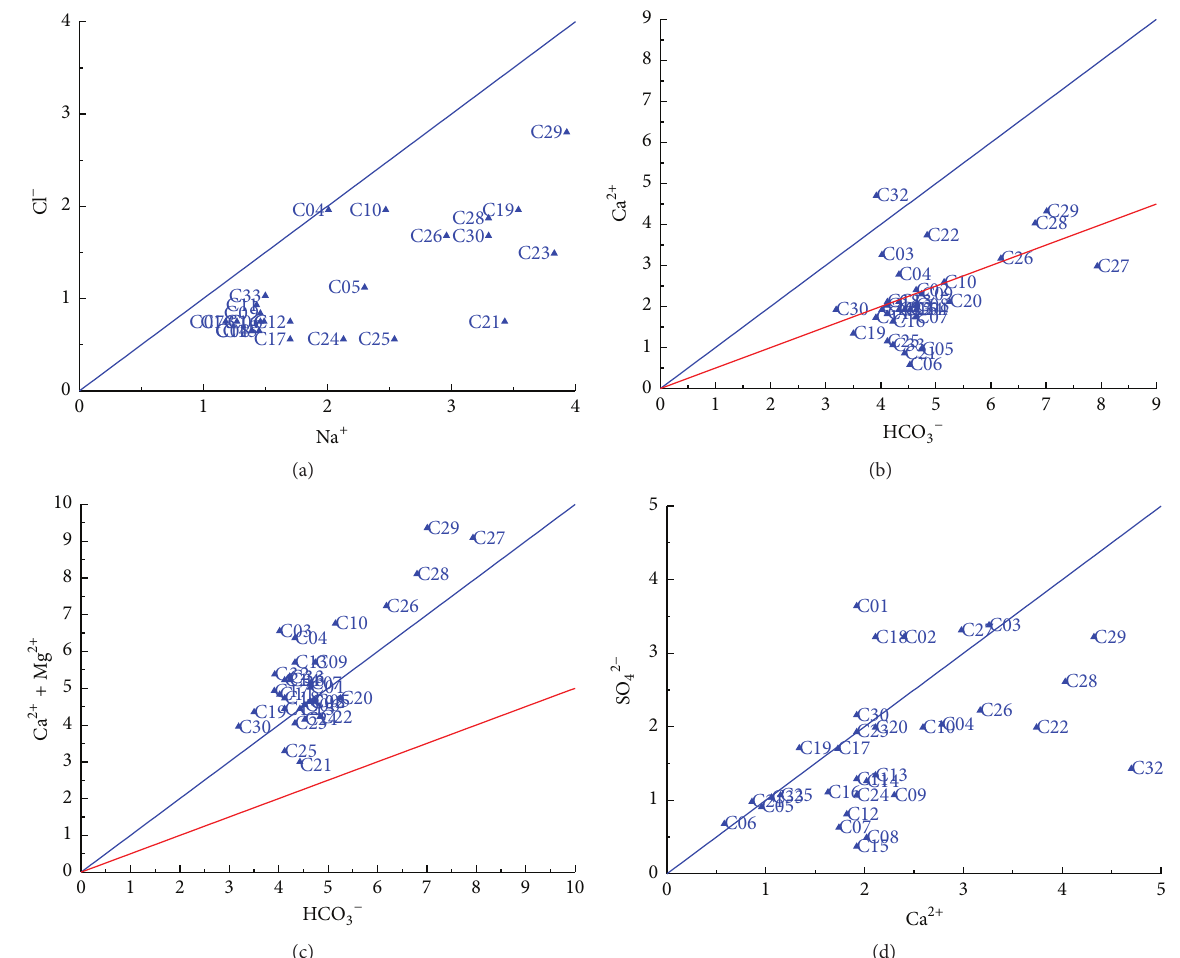
Figure 6: Plots of (a) Na + versus Cl − , (b) Ca 2+ against HCO 3− , (c) Ca 2+ + Mg 2+ against HCO 3− , and (d) Ca 2+ versus SO 42− (mmol/L).